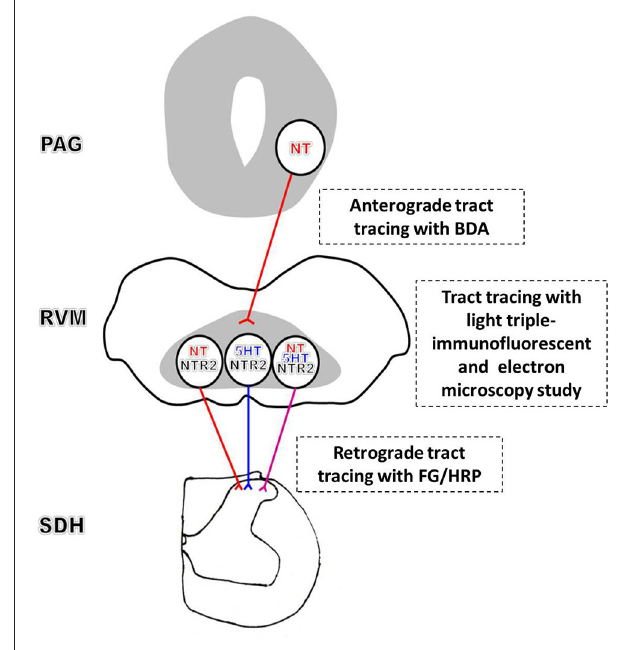
FIGURE 6 | Schematic diagram of the proposed NT-NTR2 system in the PAG-RVM-SDH pathway . The efferent NT-expressing axon terminals from the PAG synapse on spinally projecting RVM neurons. The NT-expressing nerve fibers from the PAG may primarily synapse on NTergic neurons in the RVM that display NTR2-immunopositive staining, which, in turn, project to the SDH. In addition, some of the NTR2-IR neurons, but relatively fewer than the NT-IR neurons, express 5-HT. Approximately one-third of these NTR2-IR neurons appear to utilize both NT and 5-HT as their neurotransmitters. Thus, NT and 5-HT may be co-released in the SDH to modulate nociceptive